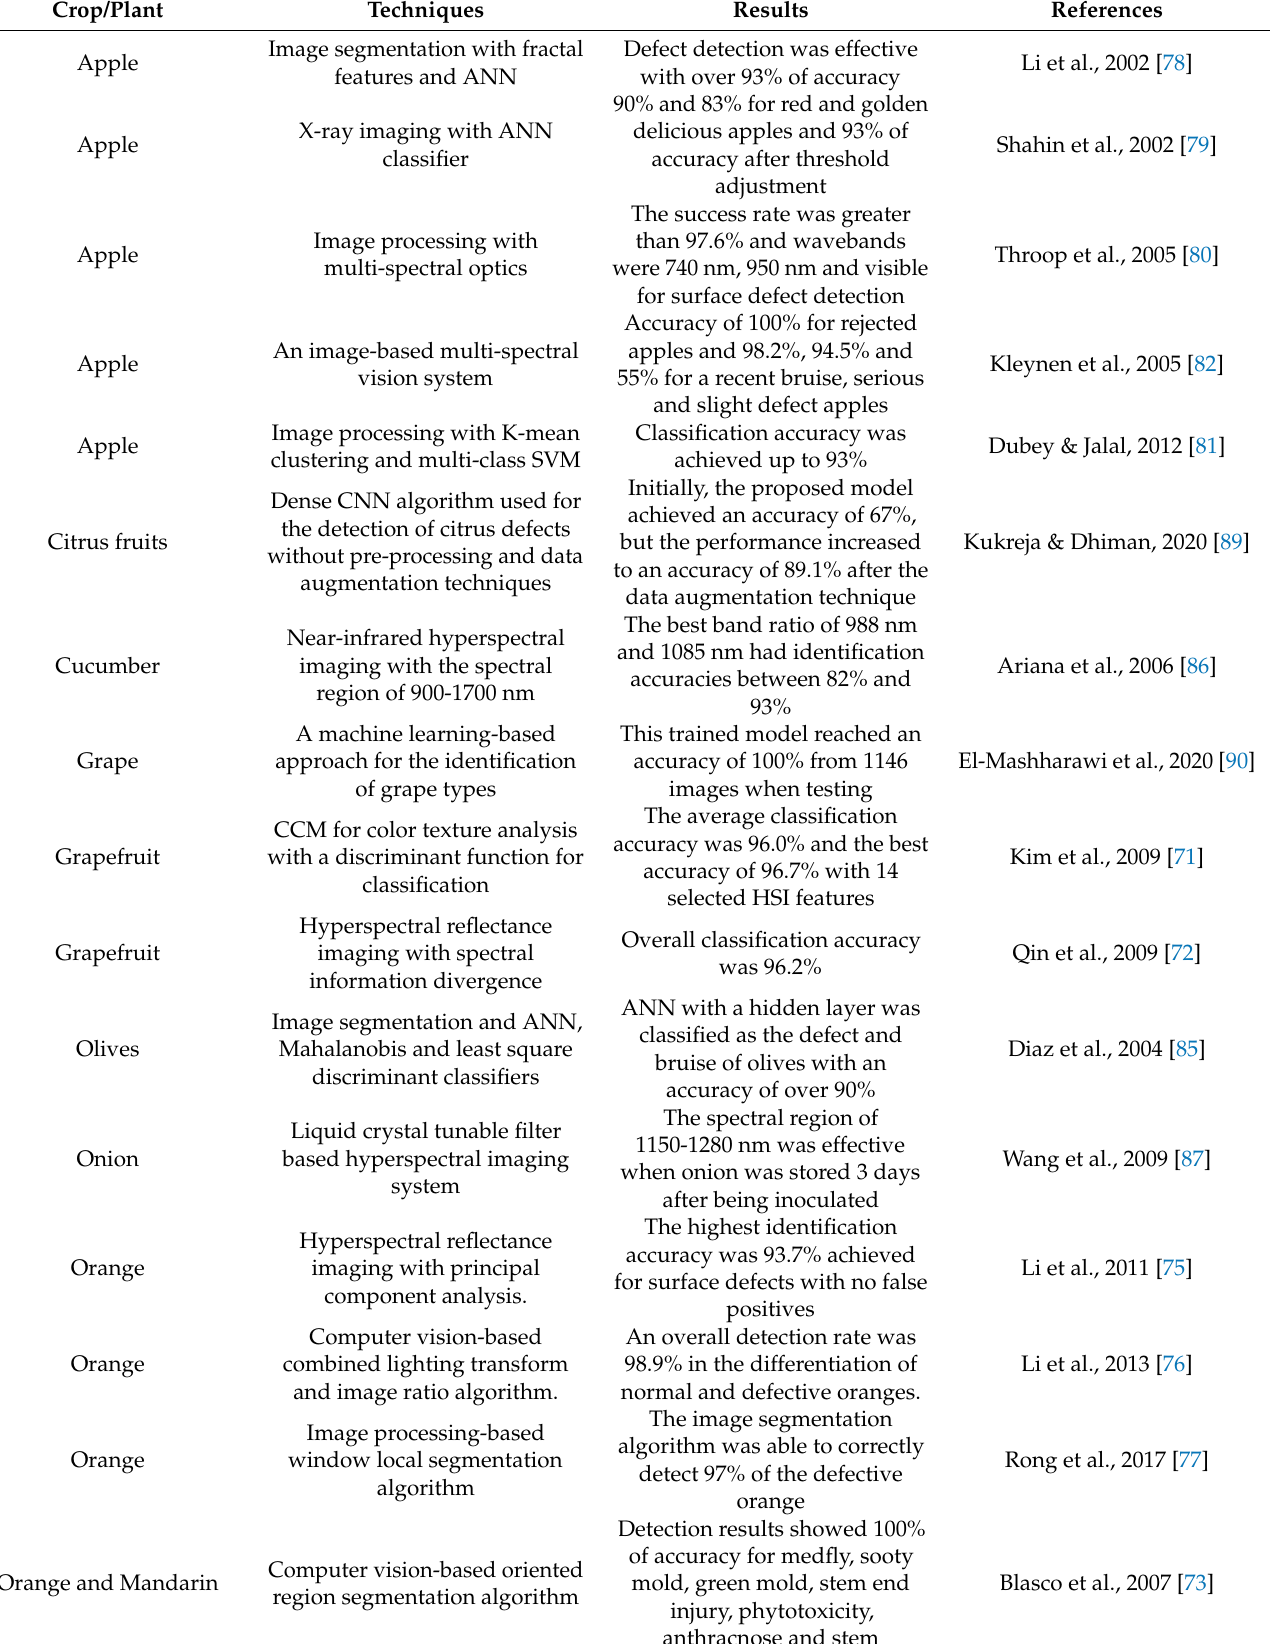
Table 3. Application of machine vision for disease detection on fruits and